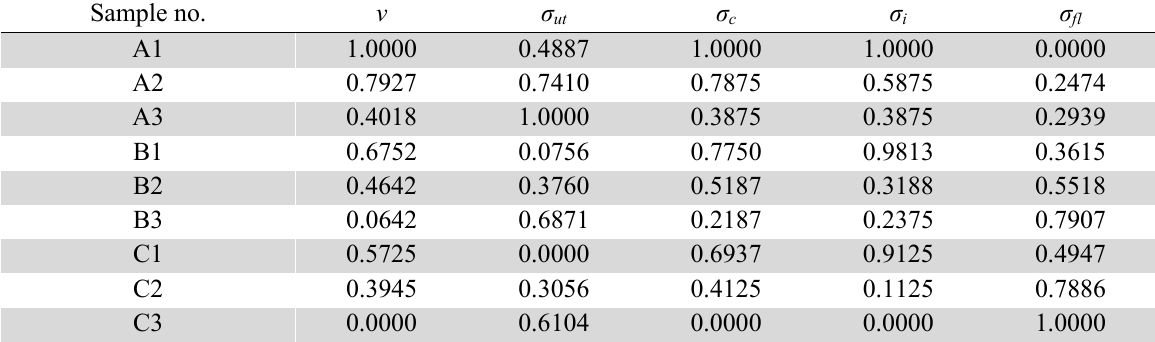
Deviation coefficients of the responses Sample no.